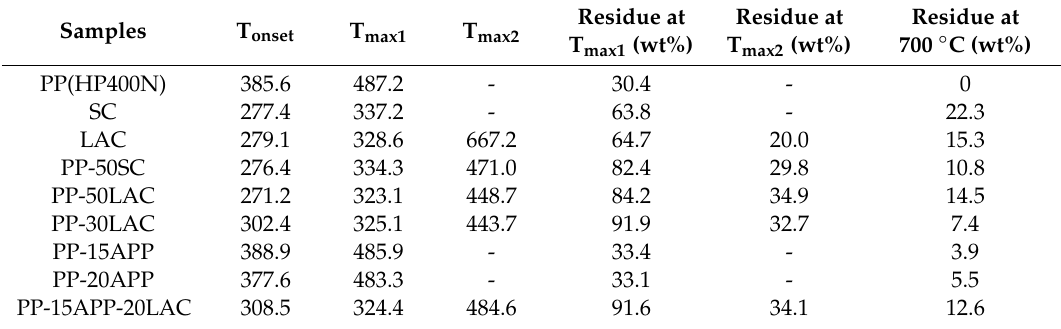
Thermogravimetric analysis (TGA) data of neat PP, casein (LAC / SC), and all PP composite